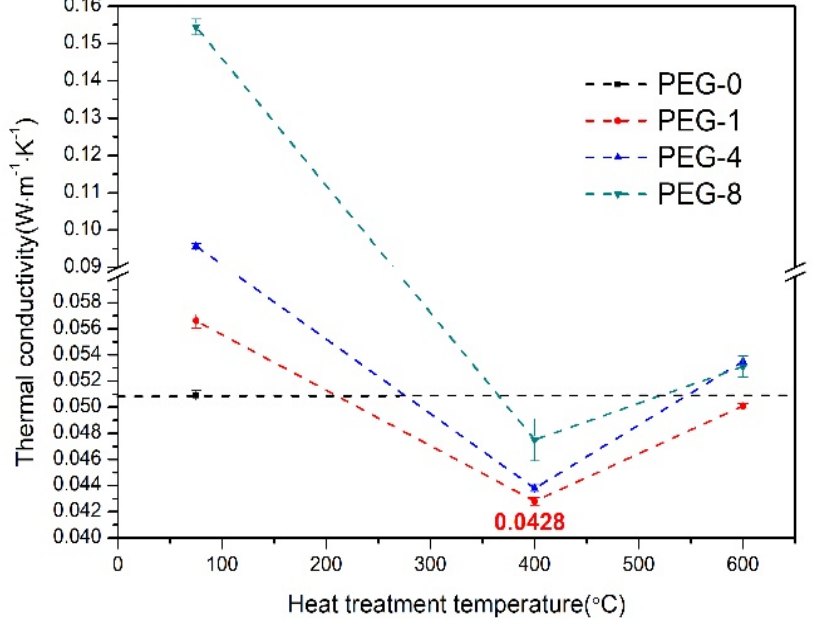
Figure 6. Room-temperature thermal conductivities for the silica xerogels modified with different amount of PEG400 before and after heat treatment at 400 and 600 °C.